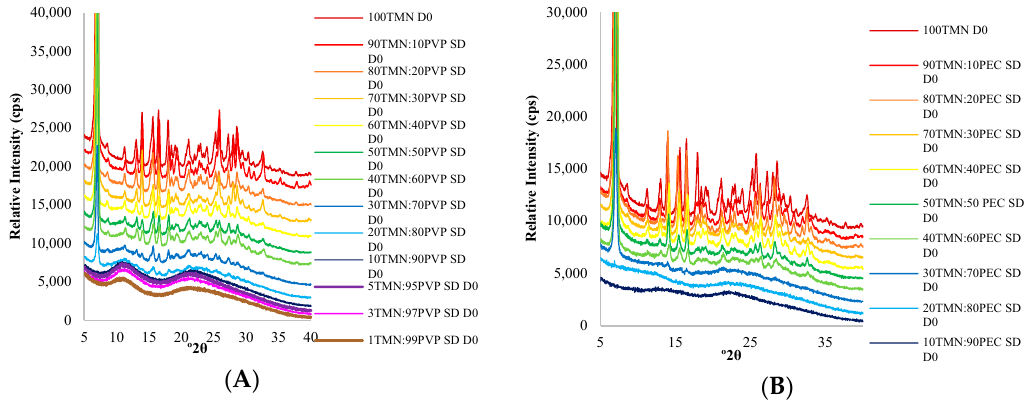
Figure 1. X ‐ ray powder diffraction patterns of ( A ) TMN:PVP solid dispersions (SD) prepared with varying ratios of thiamine mononitrate (TMN) to polyvinylpyrrolidone (PVP) immediately following lyophilization; and ( B ) thiamine mononitrate:pectin (TMN:PEC) solid dispersions (SD) prepared with varying ratios of TMN to PEC immediately following lyophilization. The diffractograms are presented from top to bottom in decreasing order of TMN concentration.